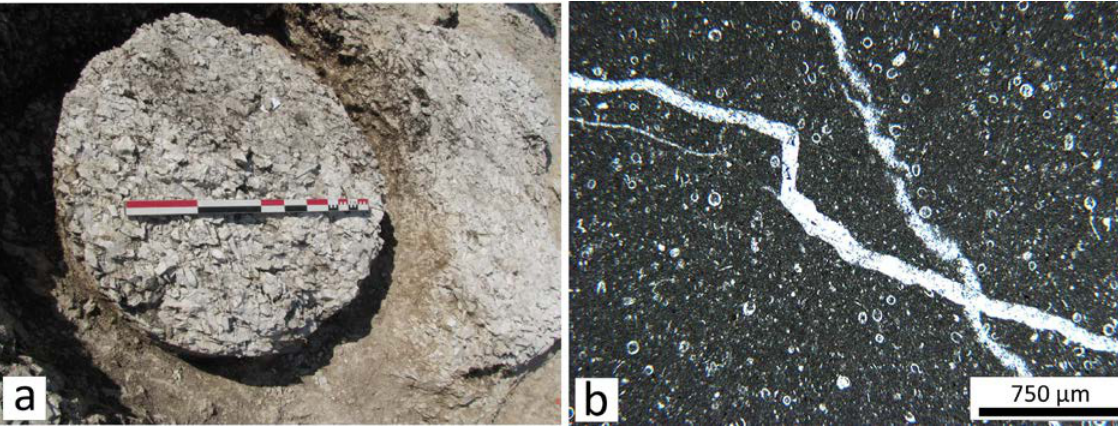
Figure 7. Modern millstone roughout of fine fractured limestone unearthed at the Jacob Bellecombette quarry (Savoie, France) (photo: Simon Painsonneau,